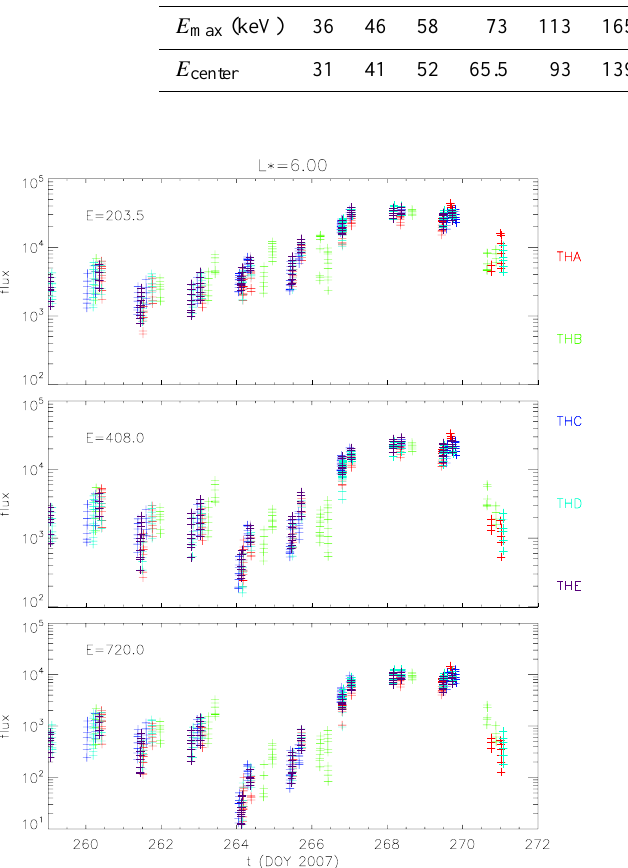
Figure 2. Particle flux, in units of #/(cm 2 ssterkeV), from three energy channels of the SST detectors on the THEMIS spacecraft, at L ∗ = 6 . 0 ± 0 . 2. The different spacecraft are identified by the color coding.